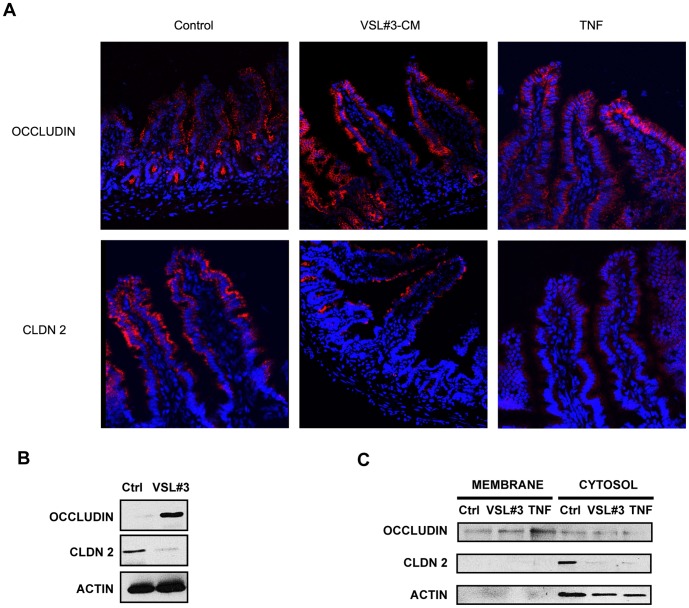
Localization and protein expression of epithelial claudin-2 and occludin following in vivo treatment with VSL#3-CM and TNF.(A), Representative confocal images (40X magnification) of ileal loops from young SAMP exposed to either VSL#3-CM, TNF or vehicle control, and immunofluorescent staining performed to detect occludin (upper panels) claudin-2 (lower panels). Epithelial occludin expression potently increased also in the villous tips after either VSL#3-CM or TNF stimulation in SAMP ilea. Claudin-2 primarily localized to the villous tips of SAMP ilea and decreased following VSL#3-CM, and particularly TNF, treatment. Results are representative of two independent experiments. (B), Representative Western blot of unfractionated IEC extracts isolated from SAMP mice treated with high dose VSL#3 showing increased expression of occludin and decreased claudin-2 protein levels compared to control. Results are representative of three independent experiments. (C), Representative Western blots demonstrating increased protein levels of occludin in membrane vs. cytosolic fractions of IEC from SAMP ileal loops treated with either VSL#3 or TNF compared to control. Claudin-2 protein was predominantly expressed in cytosolic vs. membrane fractions, and decreased following treatment with both VSL#3-CM and TNF compared to control. Results are representative of two independent experiments, pooling IEC from N = 3 mice/exp grp.